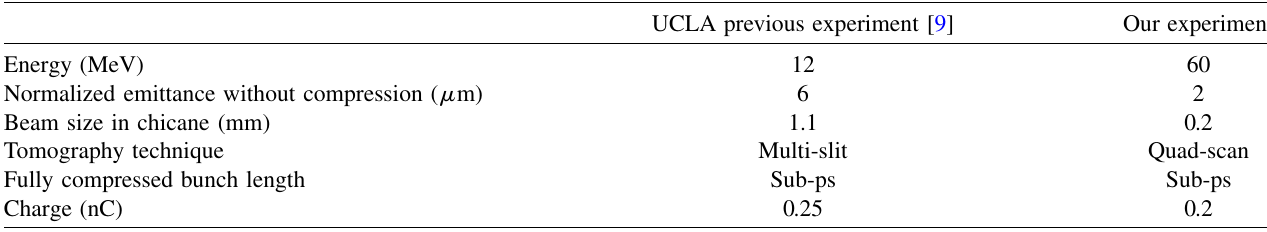
TABLE I. Comparisons of beam parameters and setups for both